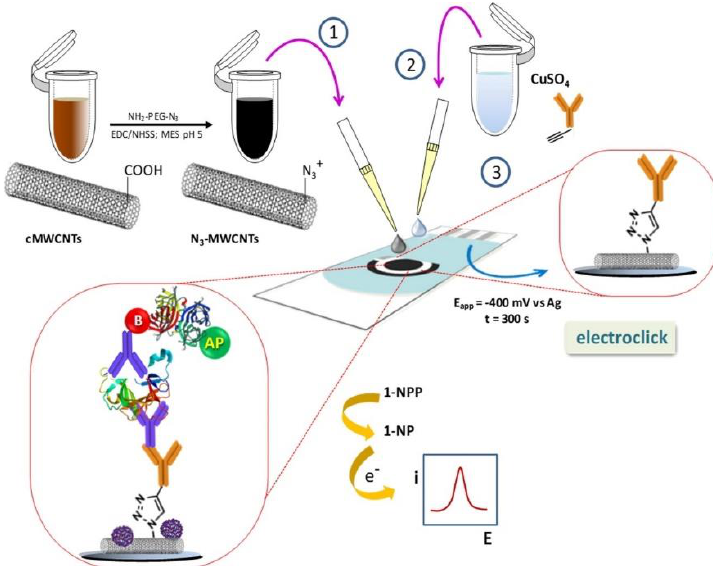
Figure 8. Schematic illustration of the steps involved in the preparation of the SPCE/MWCNT- IgG-Ab 1 -IL-1 β -Ab 2 -Bt-SAv-ALP immunosensor by electro-click chemistry, where MWCNT is multi-walled carbon nanotubes. Ethynylated anti-Ab 1 IgG is attached to azide-functionalized MWCNTs in the presence of Cu(I). Upon sandwich immunoreaction, ALP dephosphorylates 1-naphthyl phosphate to 1-naphthol, which is oxidized at the electrode. Reprinted from [123] with permission from Elsevier.